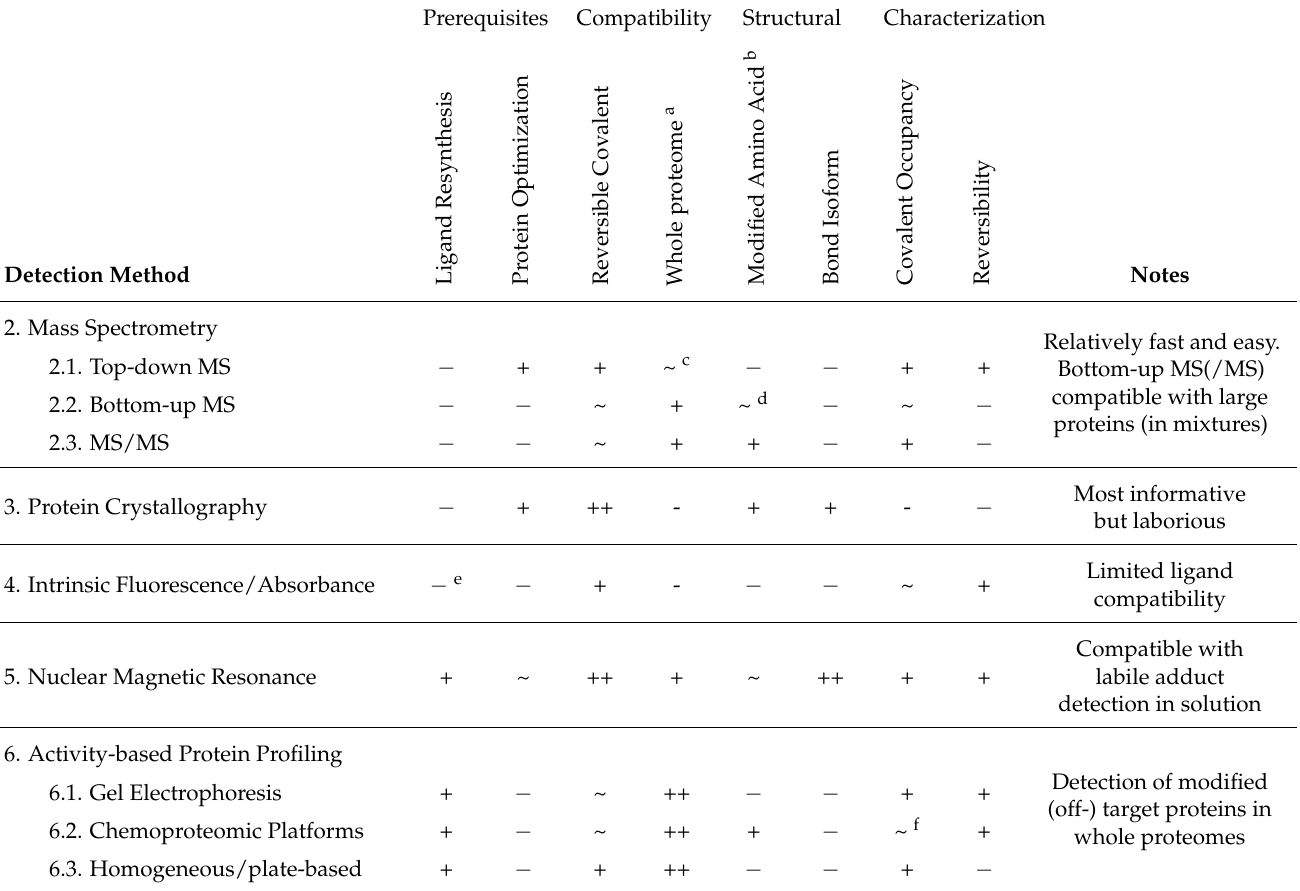
Table 1. Technologies for direct detection of covalent protein–drug adducts included in this review. Prerequisites Compatibility Structural